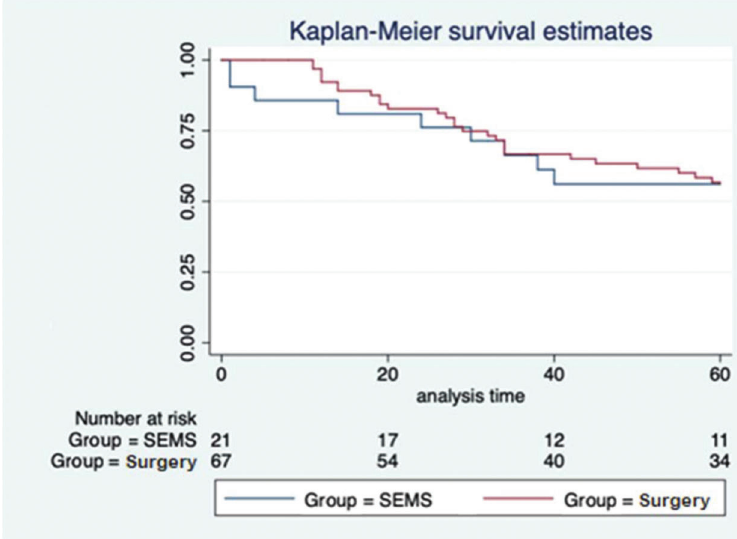
Figure 3 - Kaplan-Meier overall survival curve comparing SEMS and emergency surgery.